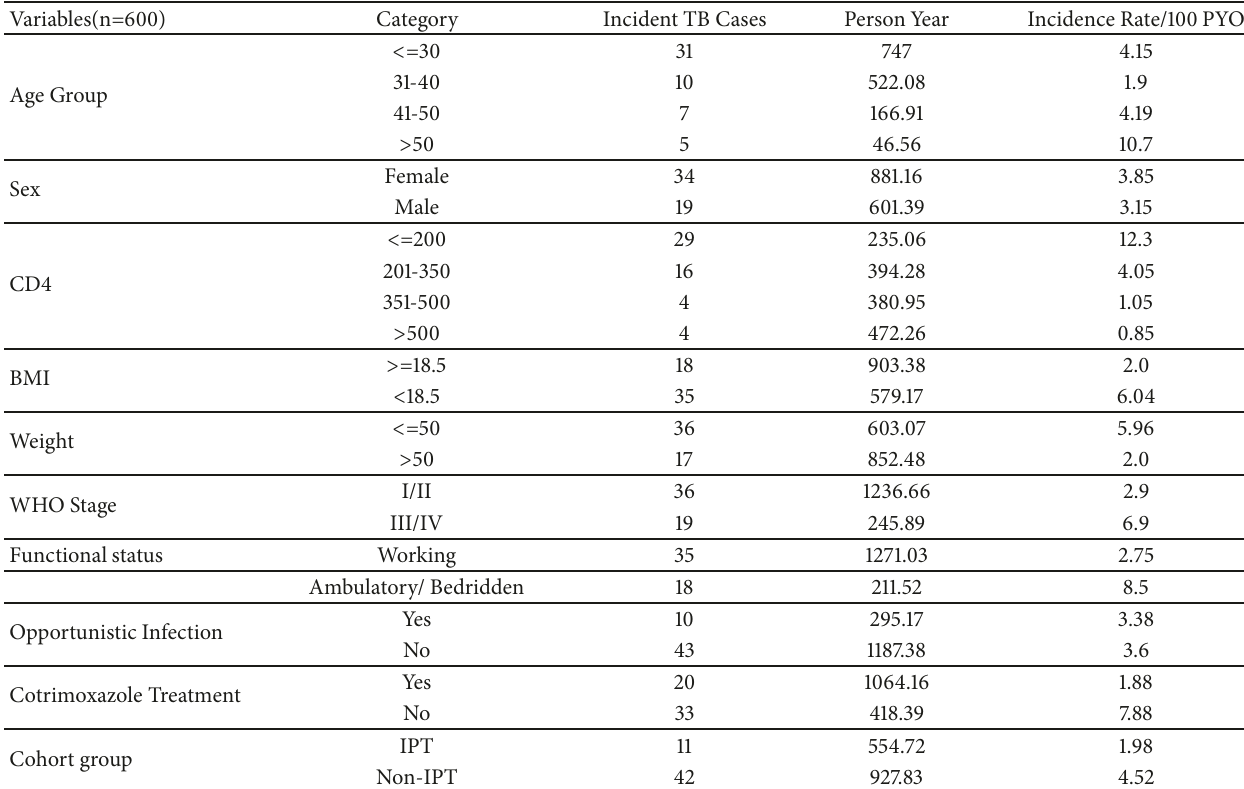
Table 3: Incidence rate of tuberculosis of PLWH at Nekemte referral hospital and Nekemte Health center followed from September 2009- September